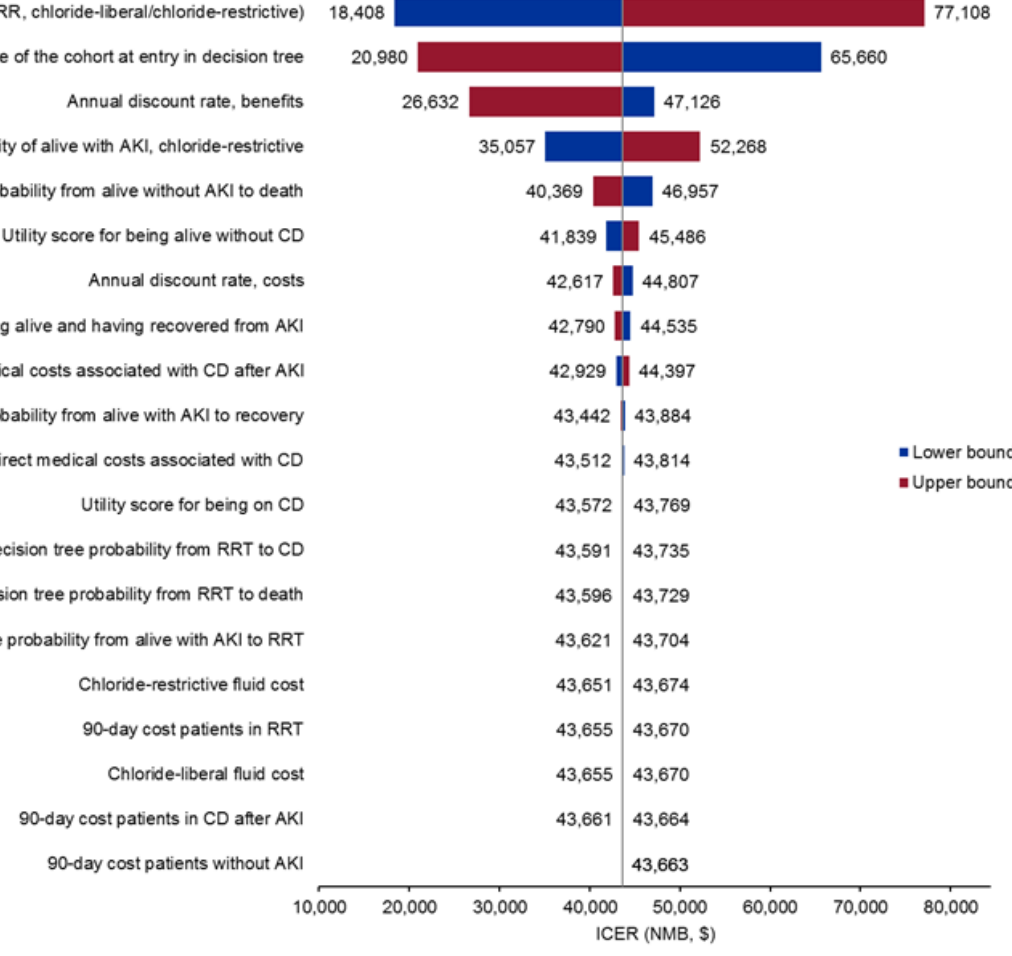
Figure 4. One-way Sensitivity Analyses of Net Monetary